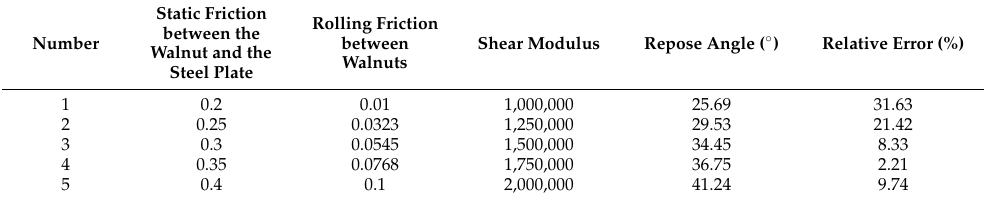
Table 6. The results of the steepest ascent